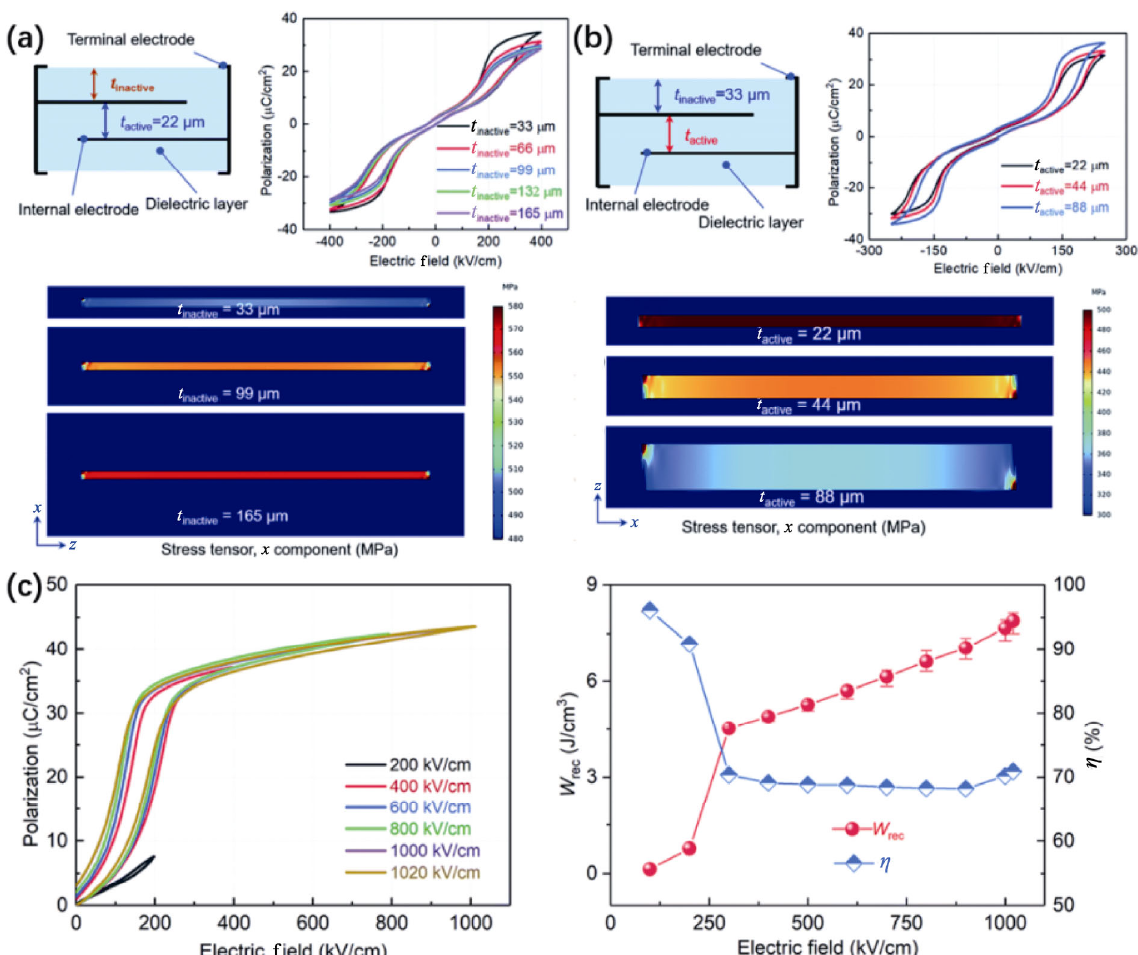
Fig. 30 (a) Effect of the thickness of inactive layer ( of the active layers with different finite-element simulations of the stress of the active layers with different of ANT–Mn MLCCs at various temperatures. Reproduced with permission from Ref. [136], © The Royal Society of Chemistry